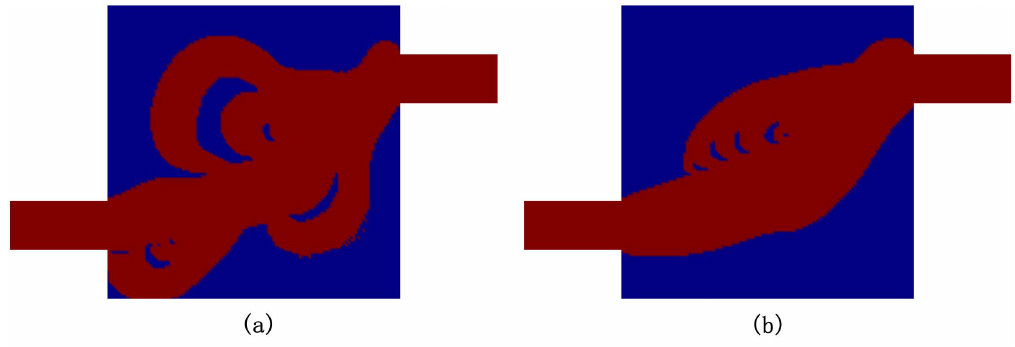
Figure 4. Two optimized Tesla valves with the value of C max is 0.351 ( a ) and 0.551 ( b ),